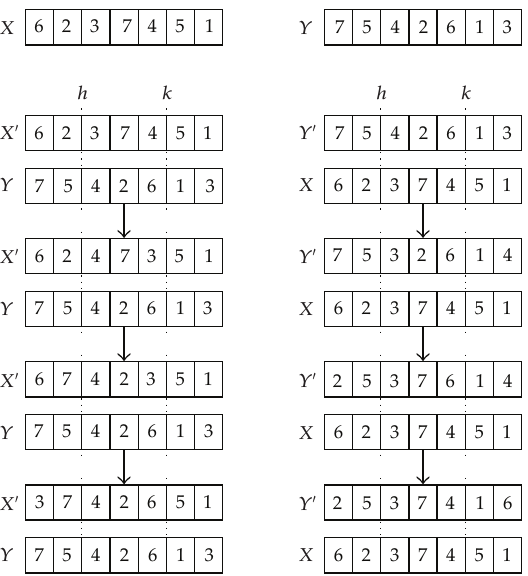
Figure 5: An example of PMX for upper